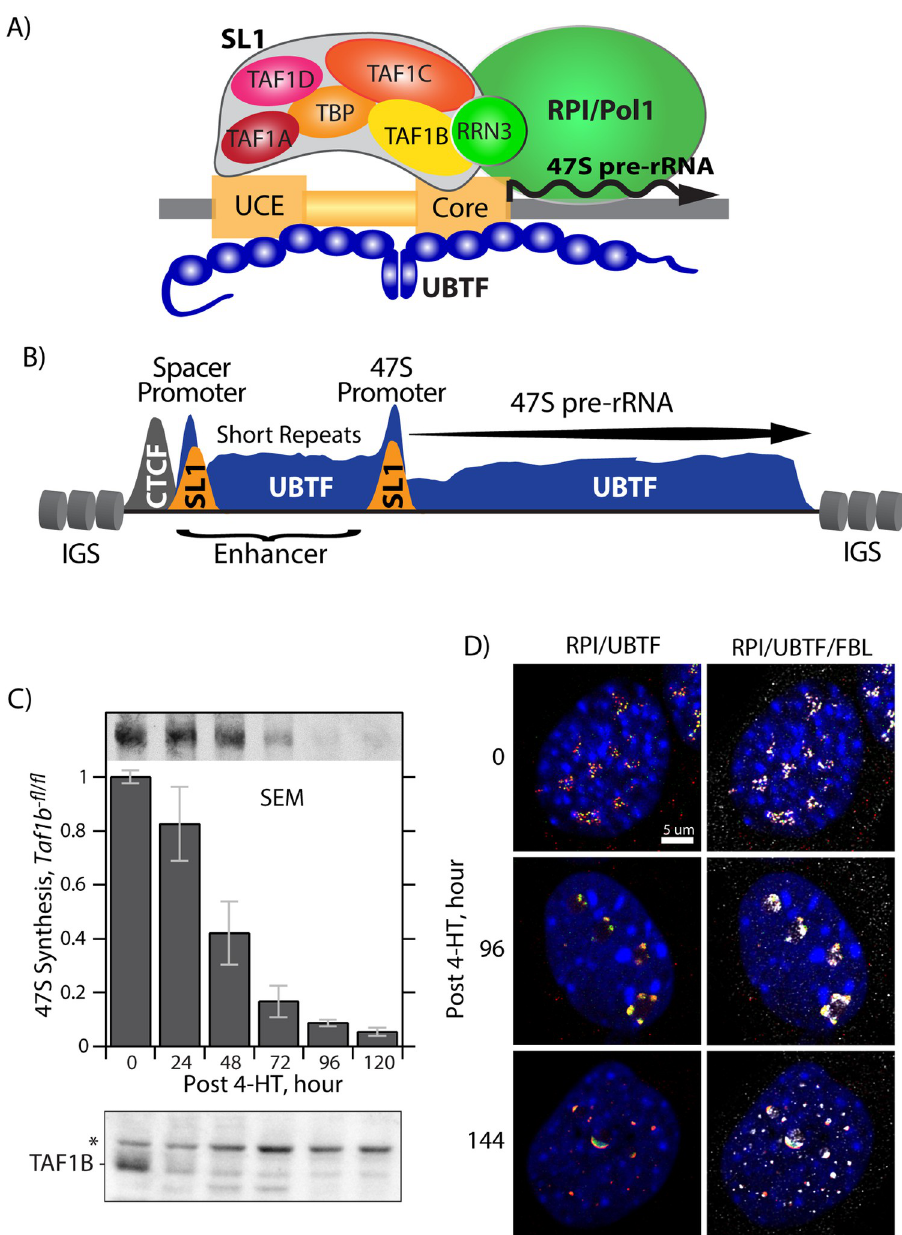
Fig 1. Genetic inactivation of the Taf1b gene disrupts rRNA synthesis and nucleolar structure in conditional MEFs. A) Schematic of the basal factors of the RNA Polymerase I (RPI/Pol1) initiation complex and their assembly on the rDNA promoter. The diagram is not intended to indicate precise factor positioning. B) General organisation of the rDNA chromatin structure in mouse. The positions of Spacer and 47S Promoter duplications, the distribution of UBTF, CTCF binding at the upstream boundary and the flanking nucleosomal IGS are indicated. C) Synthesis of 47S pre-rRNA in Taf1b conditional MEFs. 47S pre-rRNA synthesis was determined by [3H]-uridine RNA metabolic labelling following homozygous Taf1b deletion by 4-HT induction of ER-Cre. The inset in the upper panel shows a typical example of 47S pre-rRNA labelling in Taf1b fl/fl /p53 -/- /ERcre +/+ MEFs at different times after ER-Cre induction. The histogram shows quantification of 47S labelling in Taf1b fl/fl /p53 -/- /ERcre +/+ MEFs normalized to labelling in control Taf1b wt/wt /p53 -/- /ERcre +/+ MEFs. The data were derived from 6 independent analyses of MEFs derived from two floxed and two wild type embryos. Error bars indicate the SEM. The lower panel in C shows a parallel time course of TAF1B depletion, see S2 Fig for more detail. D) RPI, UBTF and fibrillarin (FBL) indirect immunofluorescence labelling in Taf1b fl/fl /p53 -/- /ERcre +/+ MEFs at different time points after 4-HT induction of Taf1b deletion, see S3 Fig for a more